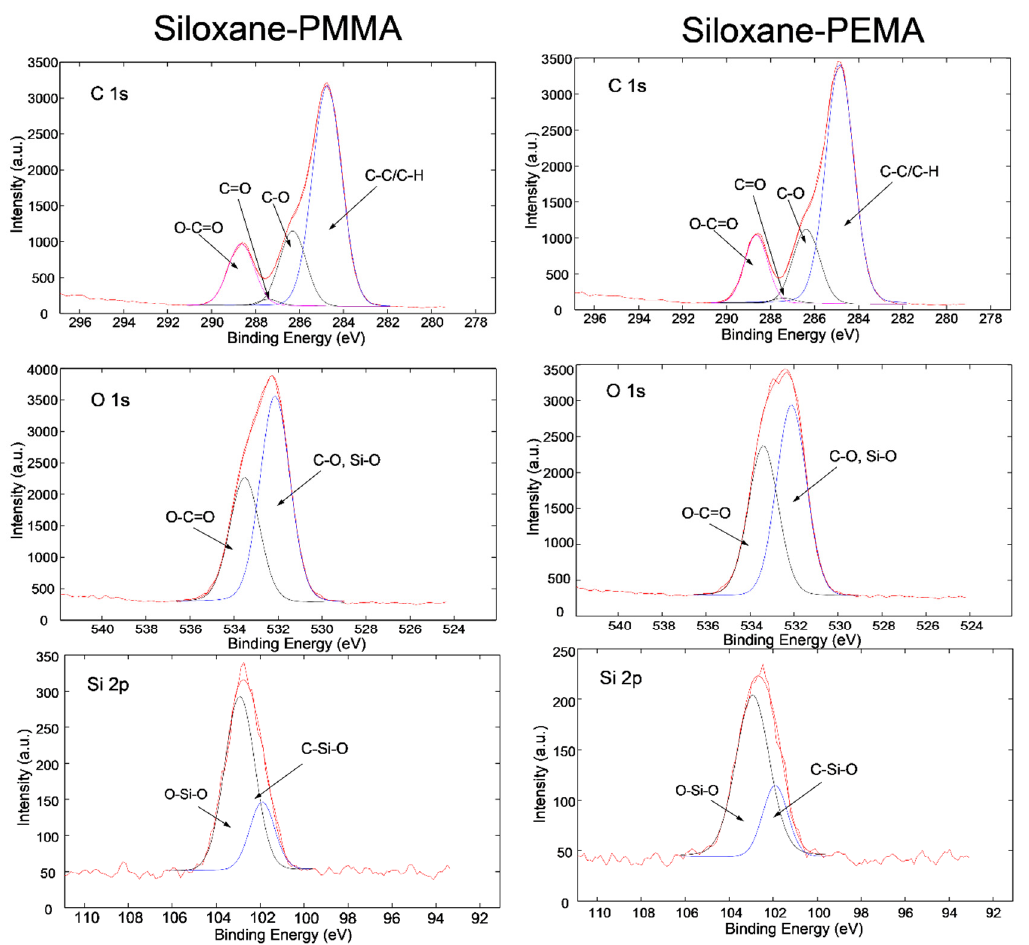
Figure 4. XPS C 1s, O 1s and Si 2p spectra recorded for siloxane-PMMA and siloxane-PEMA hybrid sol-gel coatings deposited on AA7075-T6. Spectra were deconvoluted using fitted components sub-peaks corresponding to particular species present in the coatings. The composition deduced from survey spectra is given in Table 4.